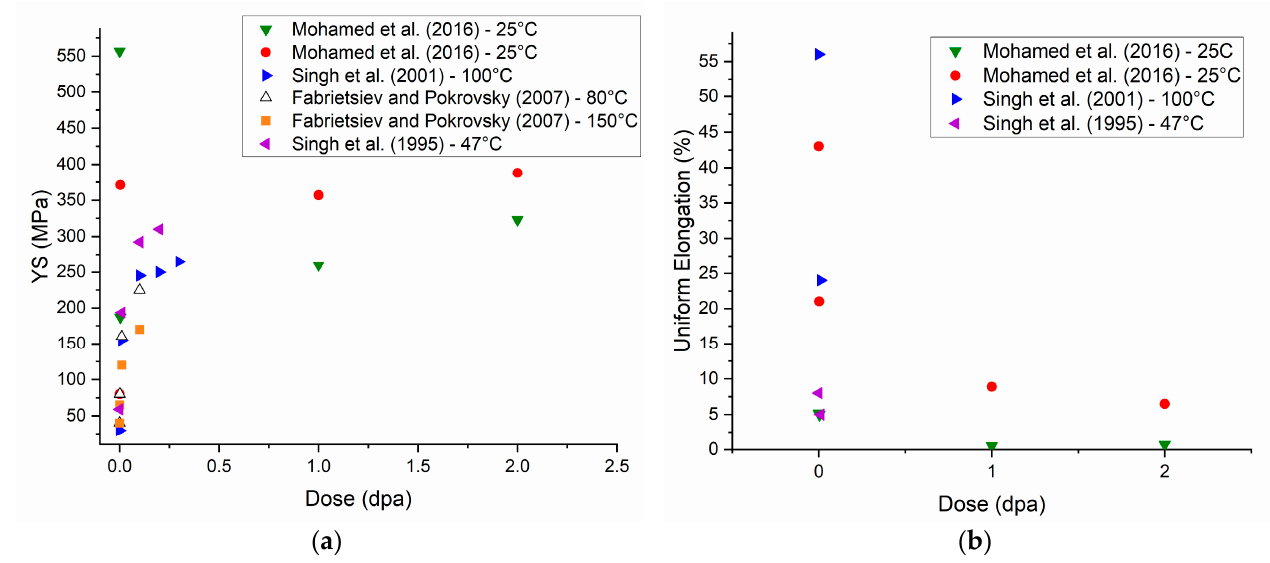
Figure 2. Literature reports of ( a ) 0.2% o ff set yield strength [34,90,92,96] and ( b ) uniform elongation data for neutron-irradiated Cu as a function of irradiation dose [34,90,96]. Irradiation hardening has two causes: source hardening and friction hardening